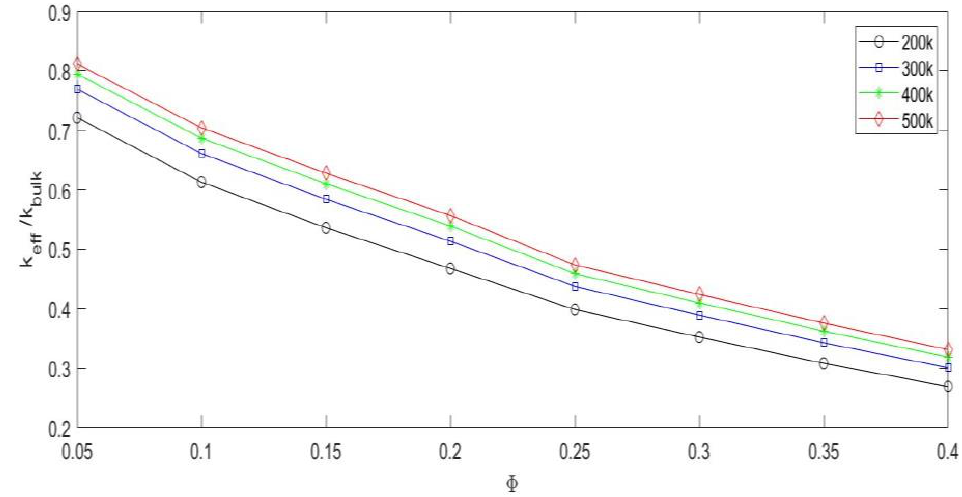
Figure 11. The effective thermal conductivity in square pores with different temperatures for AlAs.